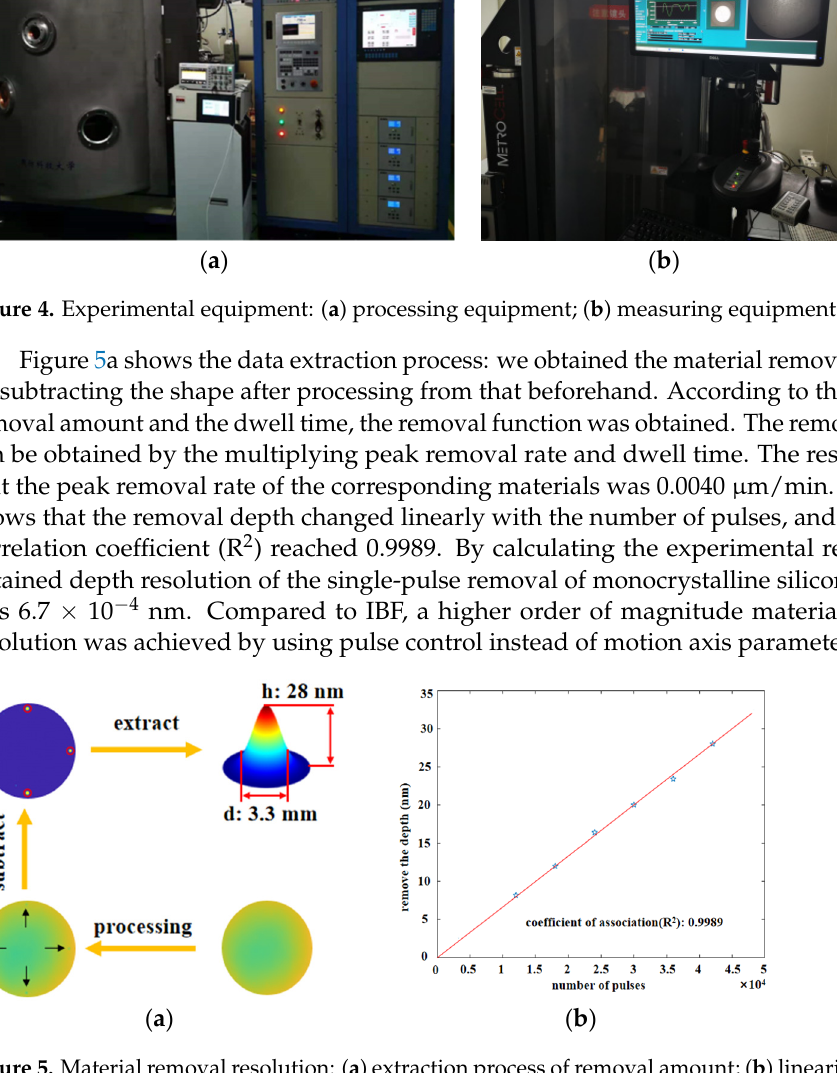
Figure 5. Material removal resolution: ( a ) extraction process of removal amount; ( b ) linearity be- tween the material removal and pulse